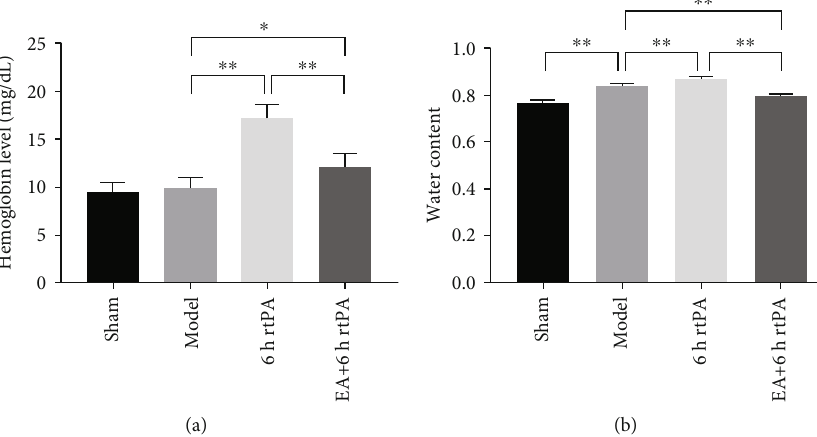
Figure 2: Hemorrhagic transformation and brain edema in each group ( n = 6 rats). (a) Hemoglobin level. (b) Brain water content. ∗ indicates p < 0 : 05 ; ∗∗ indicates p < 0 : 01 .